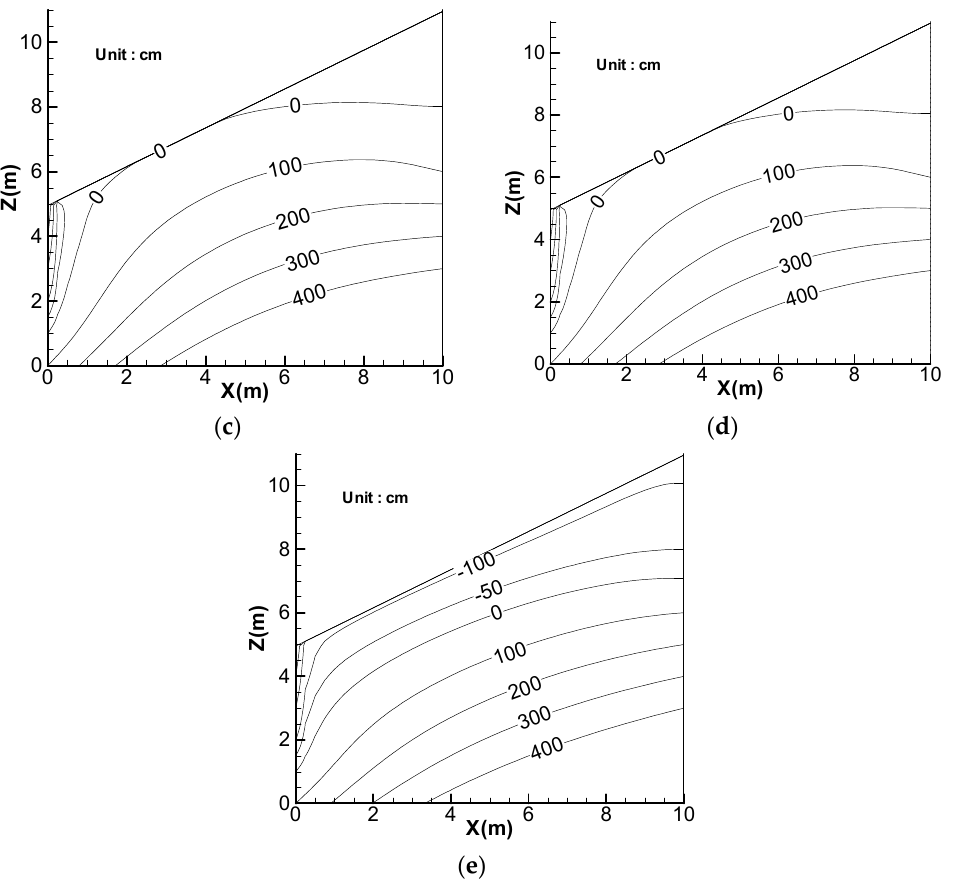
Figure 6. Pressure head contours for duration of 36 h with uniform rainfall of 500 mm at time: ( a ) 12 h; ( b ) 26.5 h; ( c ) 34 h; ( d ) 36 h; and ( e ) 48 h.